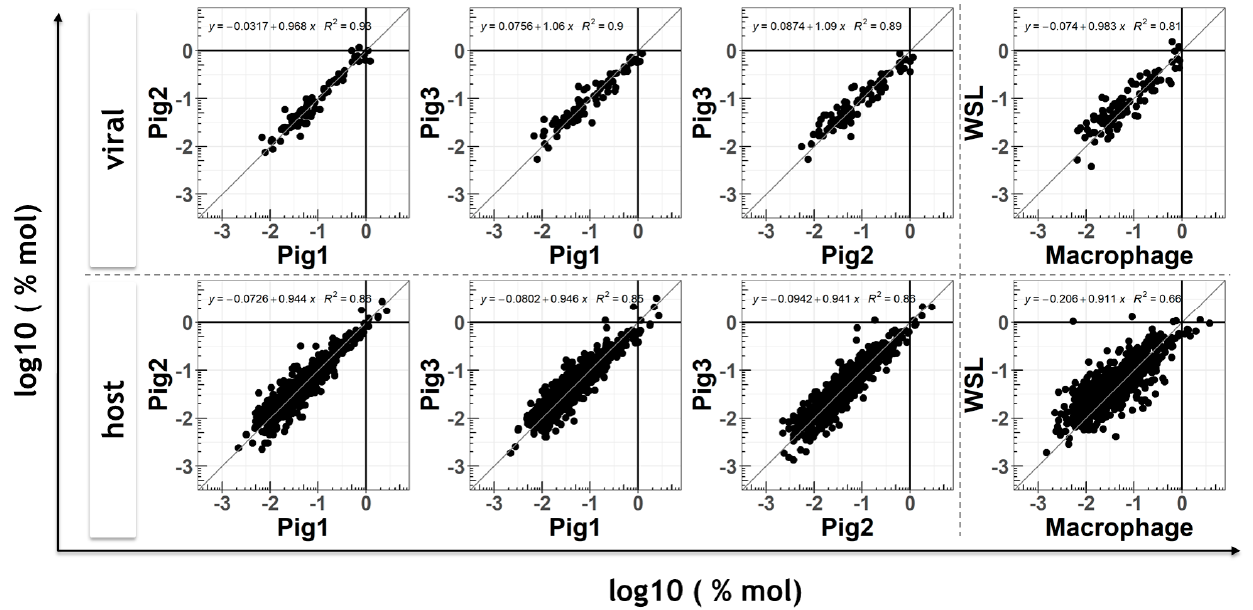
Figure 4. Comparison of viral and host gene expression levels. Scatter plots of viral (upper row) and host (lower row) protein levels representing moM Φ preparations from different pigs and WSL cells (far right panels). Mean expression levels (%mol concentrations) of at least 3 biological replicates are shown after log10 transformation (data taken from Supplementary Table ‘S7_MS-quantification.xlsx’). N = 3 for the comparison of individual pigs. In the right panels, the means of 9 moM Φ and 3 WSL samples are shown. The dissecting lines are shown as references in gray.